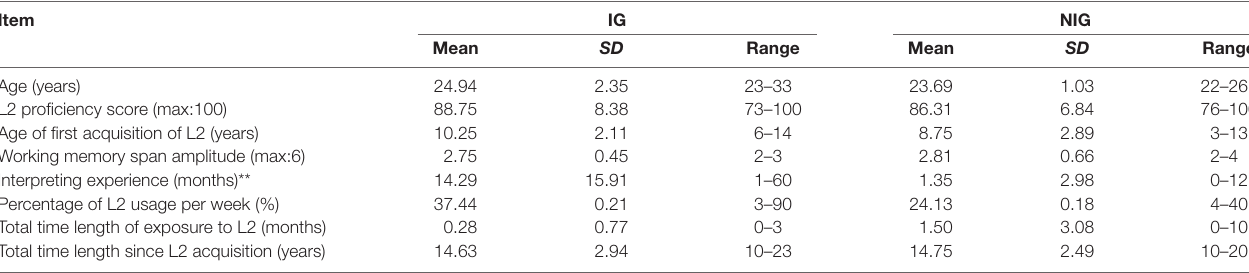
TABLE 1 | Characteristics of participants in the study.